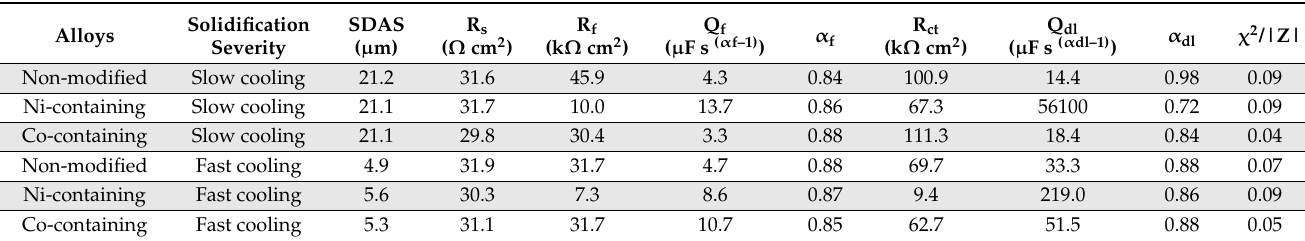
Table 1. Impedance parameters obtained from the fitting of the EIS data for the Al-Si-Fe-Cu-Zn (-Co, -Ni) alloys in 0.6 M NaCl